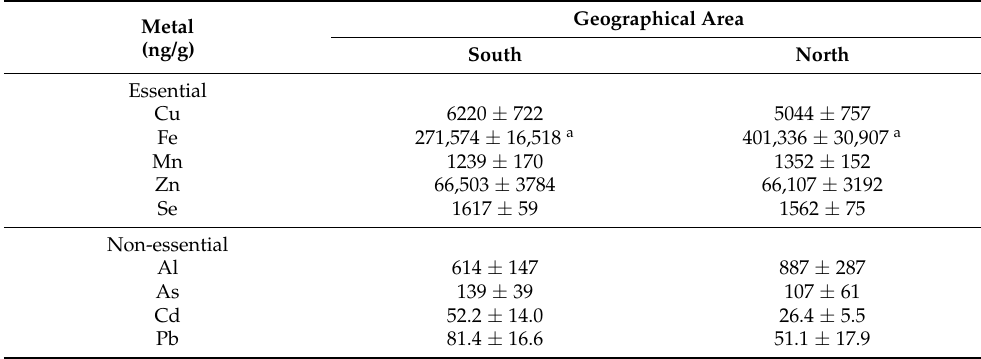
Table 1. The levels of essential and non-essential metals (mean ± SEM) in ovarian tissues of free- ranging queens inhabiting two different areas of